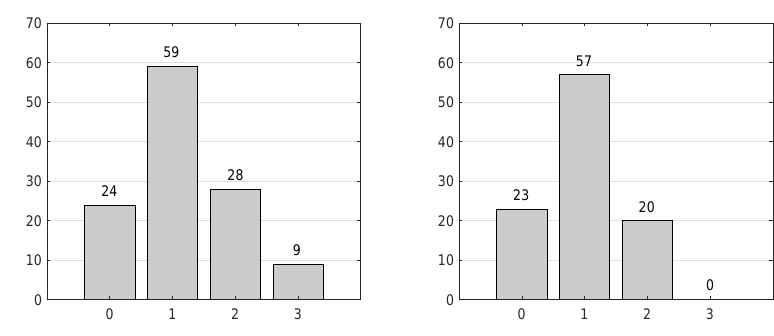
Figure 1: The histograms of the two example trace